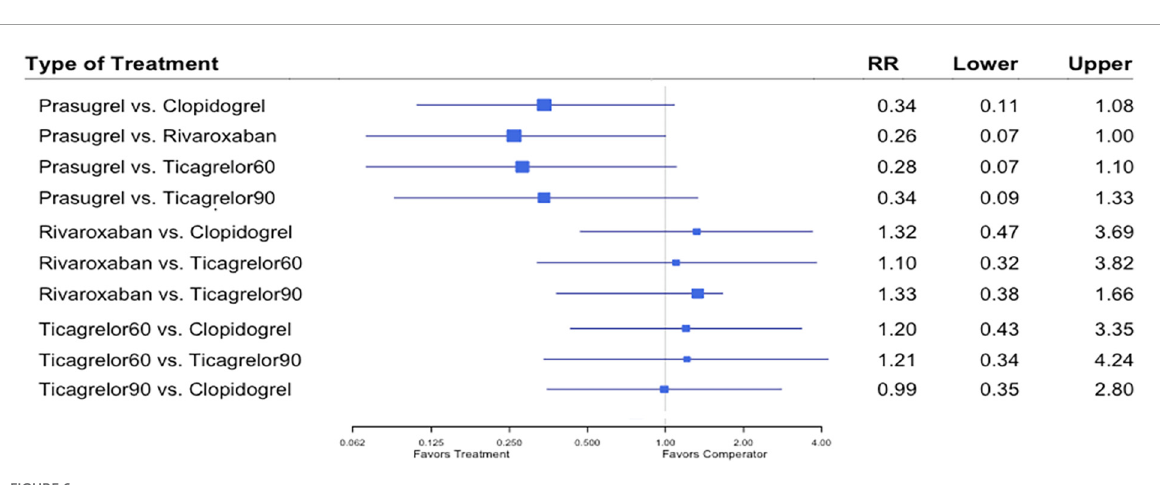
FIGURE6 A network meta-analysis of the association between anti-thrombotic therapy and stent thrombosis in patients with chronic coronary syndrome and prior percutaneous coronary intervention. Net-work Meta-analysis of the Association Between anti-thrombotic therapy and stent thrombosis. The size of squares is proportional to the weight of each study. Horizontal lines indicate the 95% CI of each treatment; diamond, the pooled estimate with 95% CI; and RR, relative